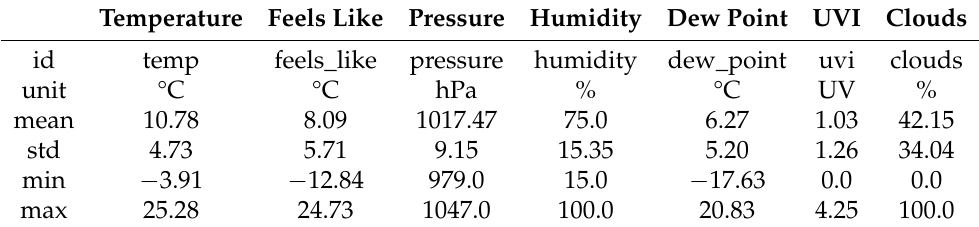
Table 1. OpenWeatherMap data retrieved and used in